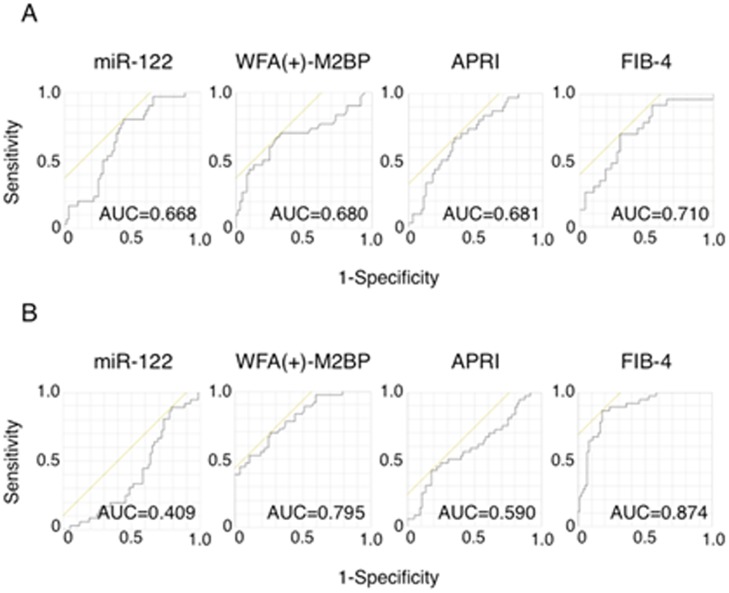
ROC curve for serum miR-122 levels, serum WFA(+)-M2BP levels, APRI and FIB-4 in the patients with HBV (A) or HCV infection (B).ROC, receiver operating characteristic; APRI, AST to platelet ratio index; FIB-4, Fibrosis 4.